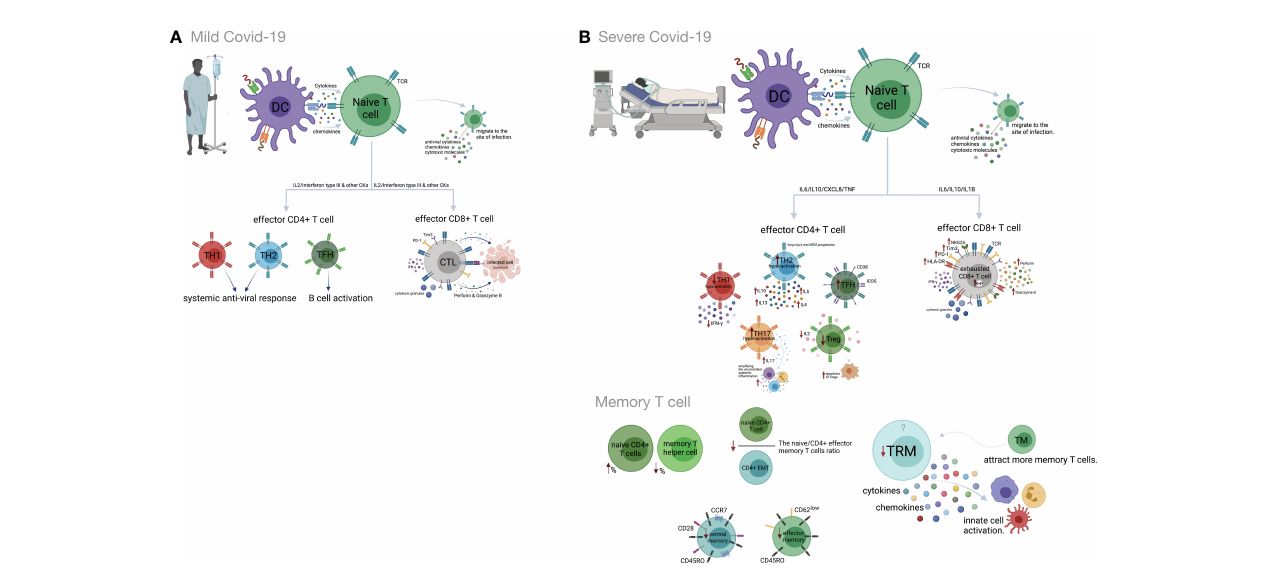
FIGURE 2 Cell-mediated immune responses during COVID-19 progression in mild versus severe disease. (A) Dendritic cells (DCs) promote activation of T cell responses by presentation of SARS-CoV-2 antigenic peptides in major histocompatibility complex (MHC) molecules along with costimulatory interactions and the secretion of chemokines and cytokines. T cell responses can mainly be polarized into T helper (Th) cells and effector cytotoxic cells (CTLs). In mild COVID-19, a higher proportion of Th1 cells plays an important role in defense against the virus by producing interleukin-2 (IL-2) and interferon- gamma (IFN- g ). Th1 cells and the cytokines they secrete activate macrophages, CTLs and natural killer (NK) cells. The Th2 cells stimulate the humoral response and activate eosinophils, basophils and mast cells through IL-4 and IL-5 secretion. The T follicular helper (Tfh) cells are essential for the formation of germinal centers (GCs), B cell maturation and immunoglobulin (Ig) production. CD8 + T cells, which coordinate the protective antiviral activities in COVID-19, secrete cytotoxic granules containing perforin and granzyme B as well as IFN- g in patients who developed mild disease. (B) Lymphopenia is a hallmark feature of patients with severe COVID-19. This may be the result of the migration of enormous numbers of T cells to the lungs and other sites of in fl ammation. Both CD4 + and CD8 + T cells express strongly CD69, CD38, CD45RO, CD44, HLA-DR, programmed cell death protein-1 (PD-1), T cell immunoglobulin domain and mucin domain-3 (TIM-3) and killer cell lectin-like receptor subfamily C member 1 (NKG2A), which can represent hyperactivated, exhausted or a hypoactivated state of T cells in severe patients. Furthermore, the numbers and functions of regulatory T cells (Treg) are signi fi cantly reduced in these patients. Smaller proportions of CD4 + and/or CD8 + effector cells (CD45RO + CD45RA − CCR7 − CD28 − CD62L low ), central memory cells (CD45RO + CD45RA − CCR7 + CD28 + ) and tissue-resident memory (CD69 + CD103 + CD49a + ) T cells were